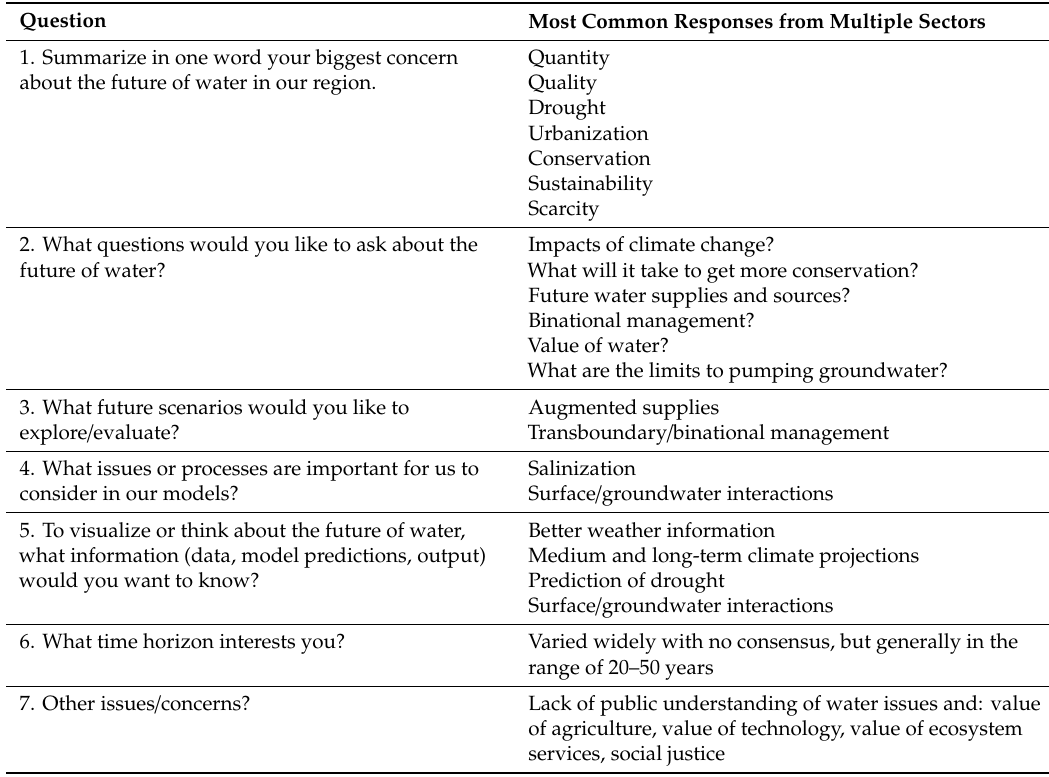
Table 1. Summary of commonalities in stakeholder responses across